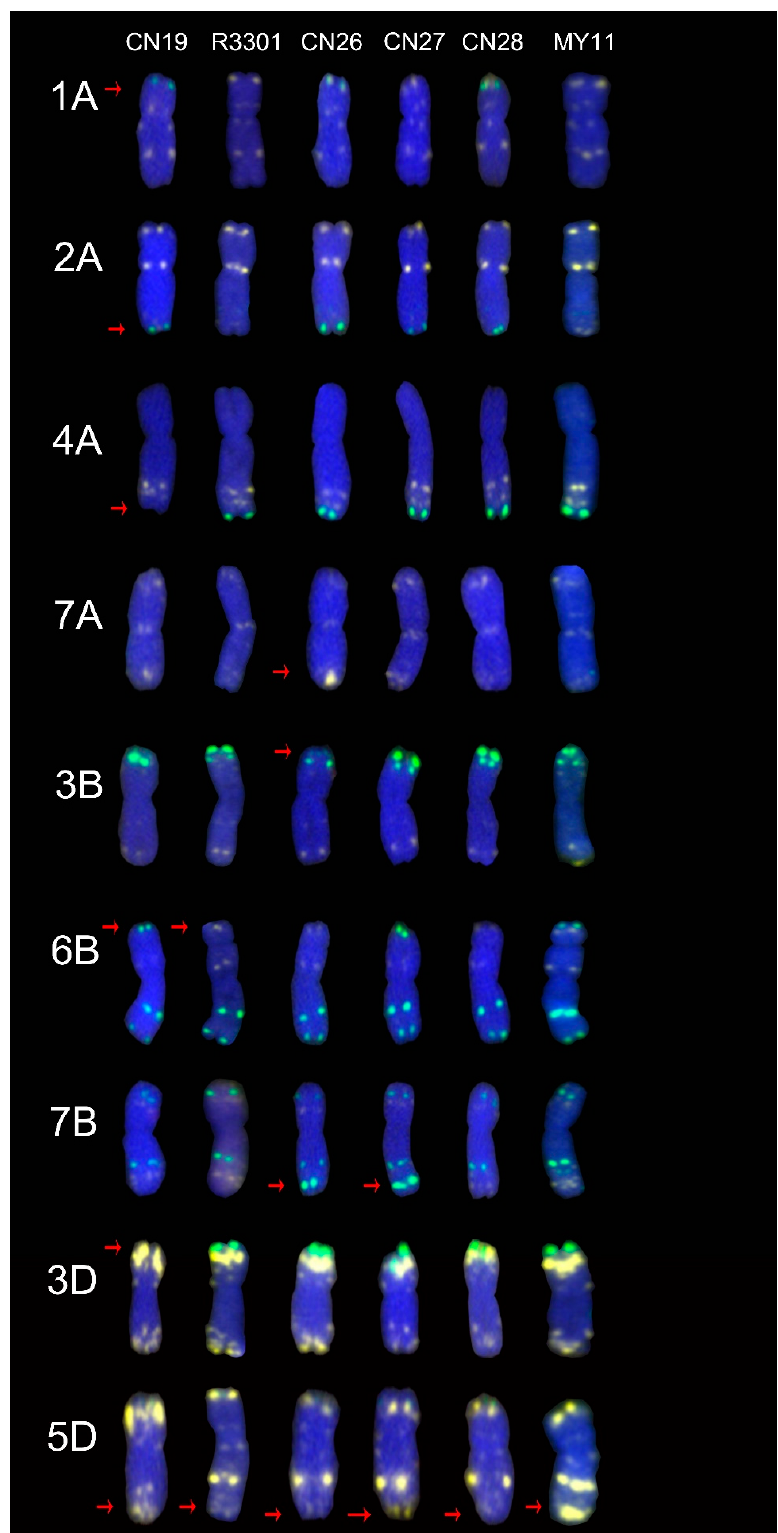
Figure 5. The differences of ND-FISH signal patterns in CN26, CN27 and CN28 cultivars when they were compared with their parents. From left to right: CN19, R3301, CN26, CN27, CN28 and MY11, respectively. The red arrows showed the mutant signal patterns on chromosomes. Yellow: Oligo-pTa535-1; Green: Oligo-pSc119.2-1; Red: Oligo-Ku, Oligo-pSc200 and Oligo-pSc250. Blue: DAPI.